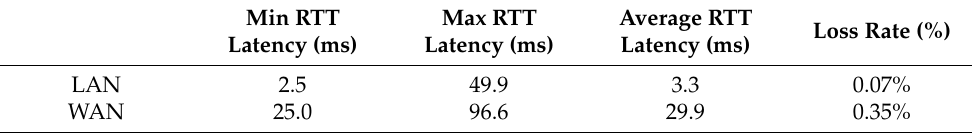
Figure 10. Network RTT latency and packet loss test of LAN and WAN. Table 2. Statistical results of network RTT latency and packet loss